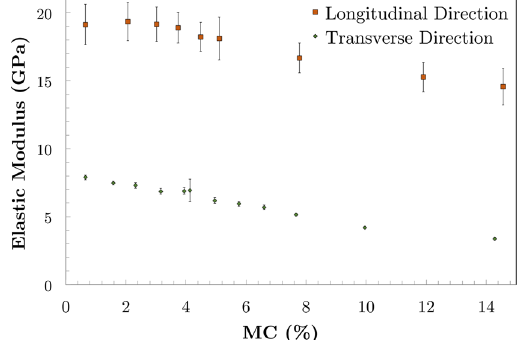
Figure 1. Experimental longitudinal and transverse nanoindentation elastic moduli of bamboo fiber walls as a function of moisture content (MC). The longitudinal elastic moduli were assessed from the surface prepared in the transverse plane in which the cellulose microfibrils were oriented approximately parallel with indentation direction. Similarly, the transverse elastic moduli were assessed from the surface prepared in the longitudinal plane in which the cellulose microfibrils were oriented approximately perpendicular to the indentation